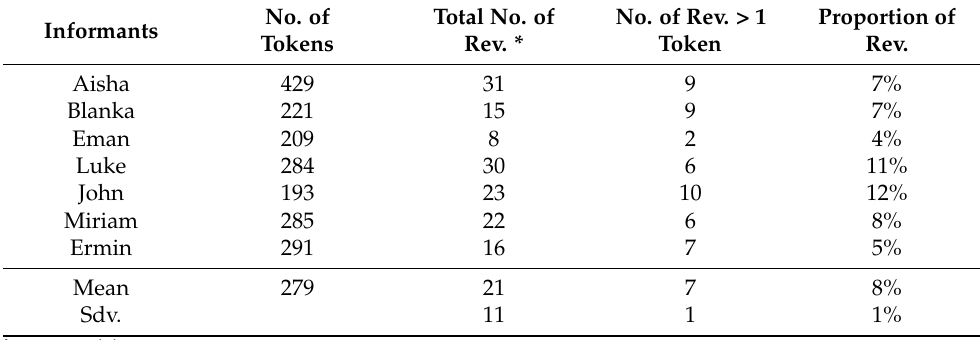
Table 2. Overview of text length and absolute number and proportion of revisions in students’ final texts from the first writing occasion.